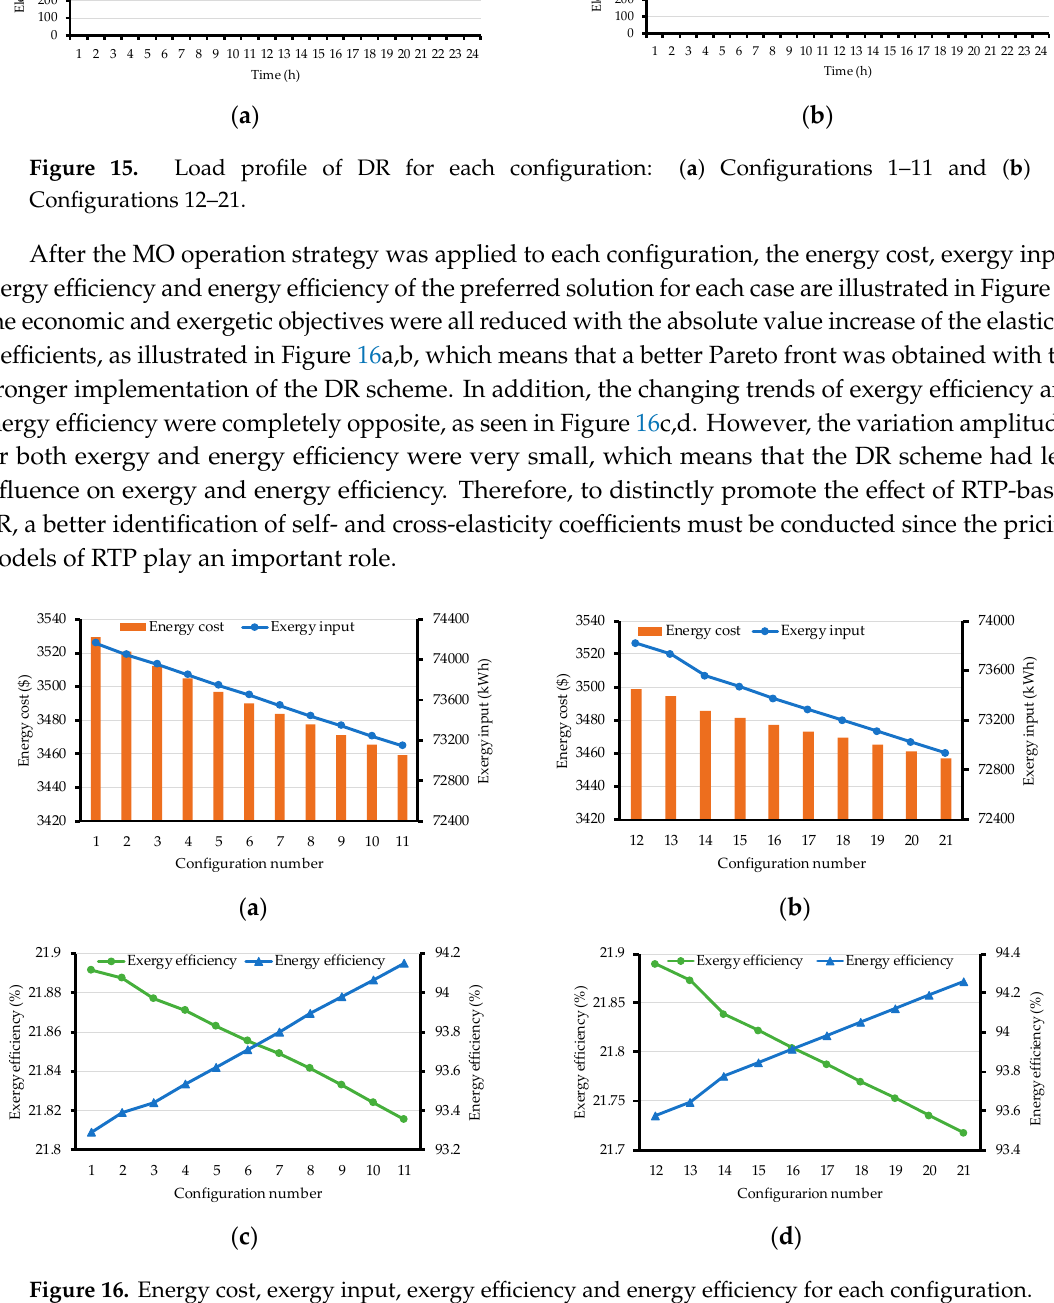
Figure 14. Values of Ps and Pc at each hour.